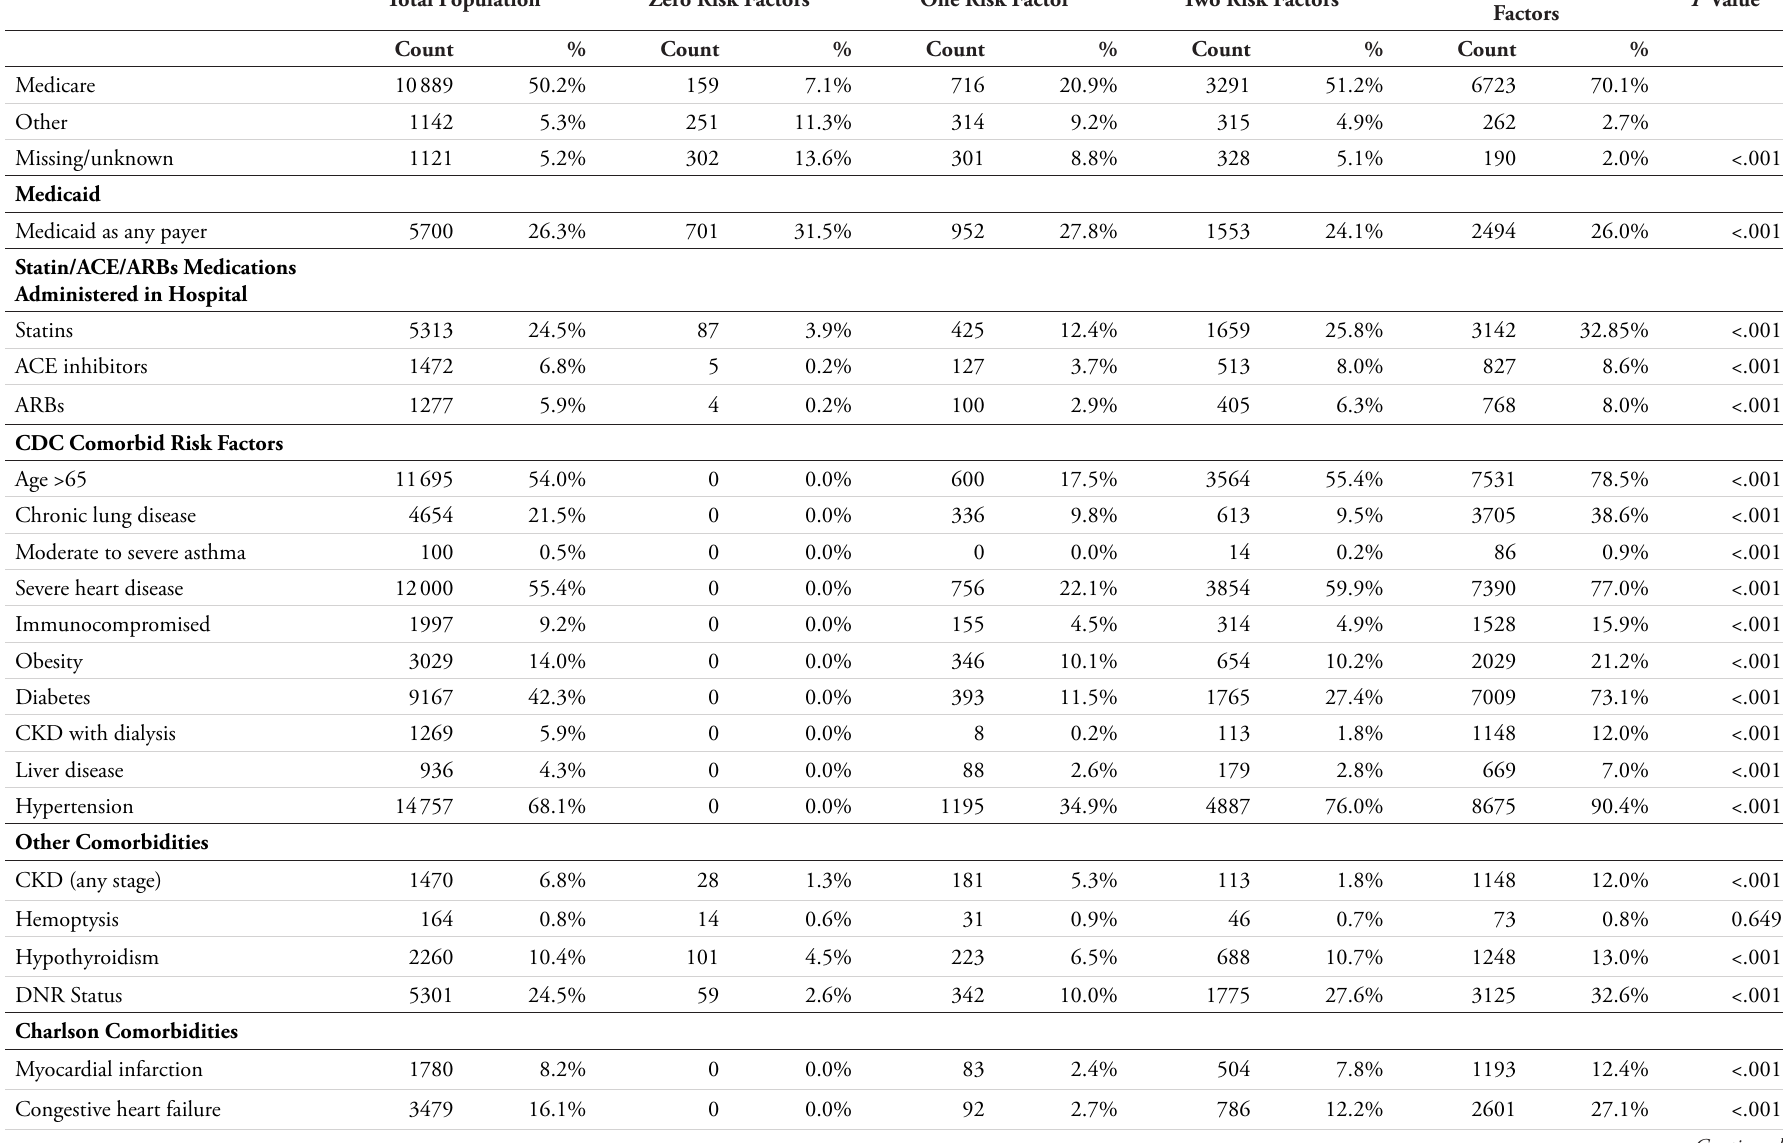
Table 1. COVID-19 Patient Characteristics by Number of Risk